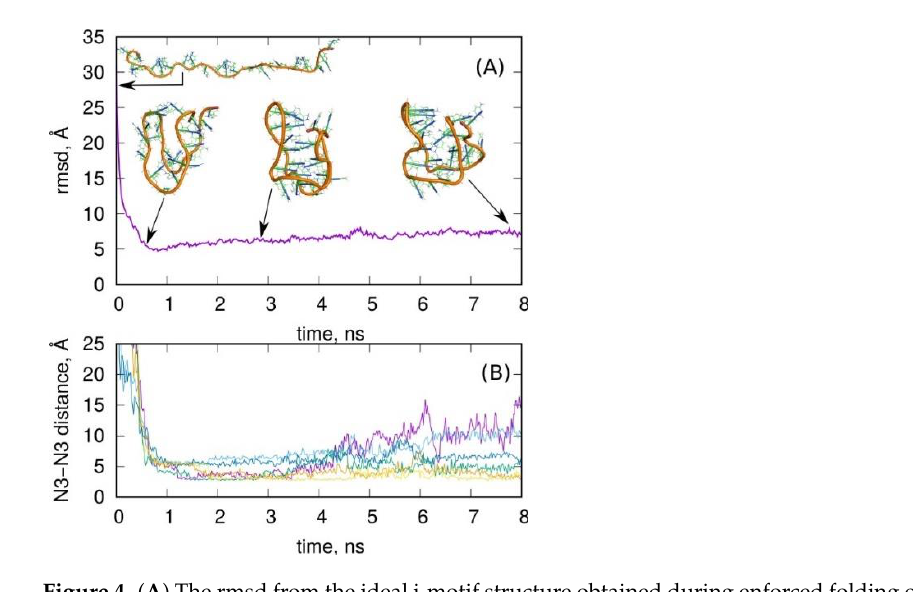
Figure 4. ( A ) The rmsd from the ideal i-motif structure obtained during enforced folding of the C-rich chain (the snapshot at the top of part ( A )) into the i-motif form. The snapshots correspond to (from the left) loosely shaped i-motif-like structure obtained using forces acting on the backbone points, the structure obtained by applying the forces acting on N3 atoms in C:C + pairs, and the structure obtained after releasing all the forces and allowing the structure to relax. ( B ) The distances between N3 atoms in C:C + pairs during enforced folding of C-rich chain into i-motif like structure. The applied force field parametrization was the bsc1.